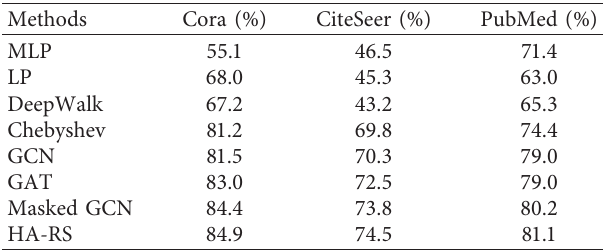
Table 2: Summary of results in terms of classification accuracies, for Cora, CiteSeer, and